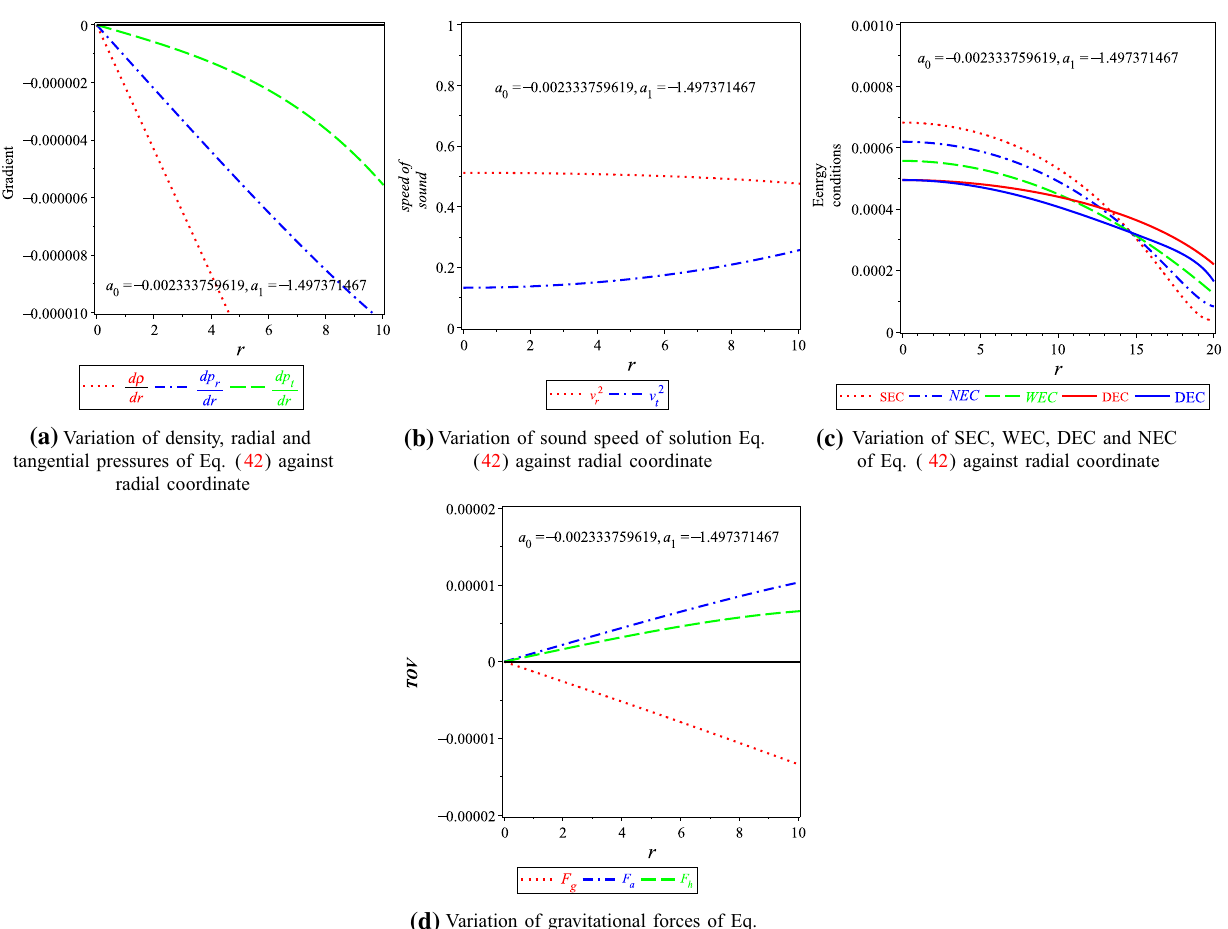
Variation of SEC, WEC, DEC and NEC of Eq. ( 42) against radial coordinate